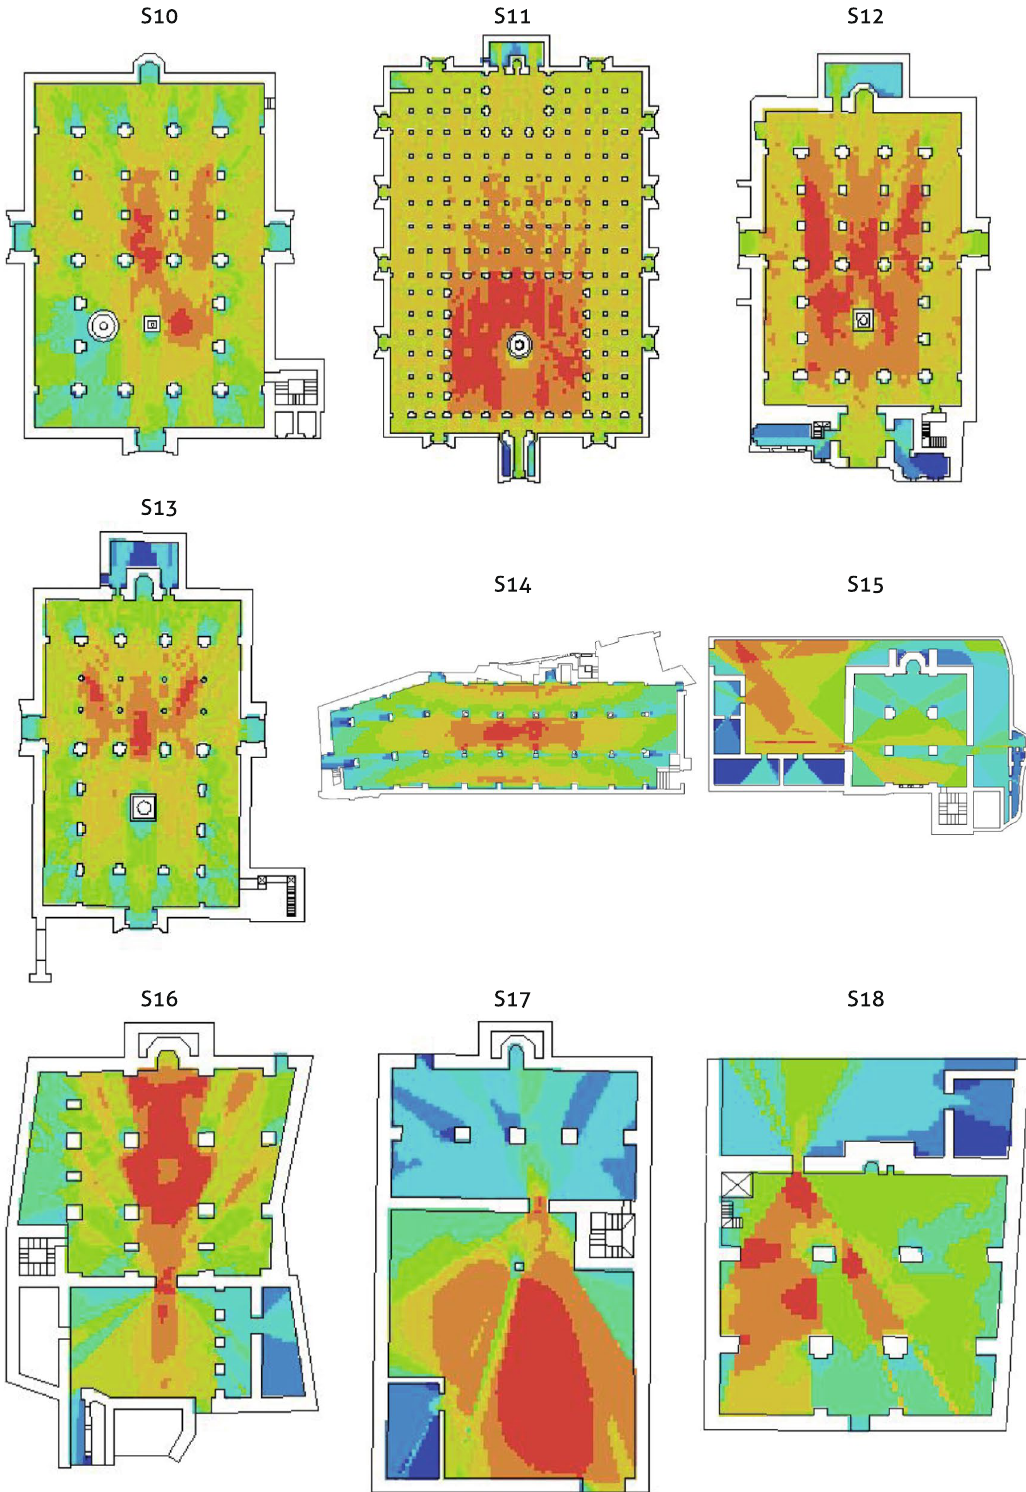
Fig. 11 VGA integration: S10–S18 (Source: the